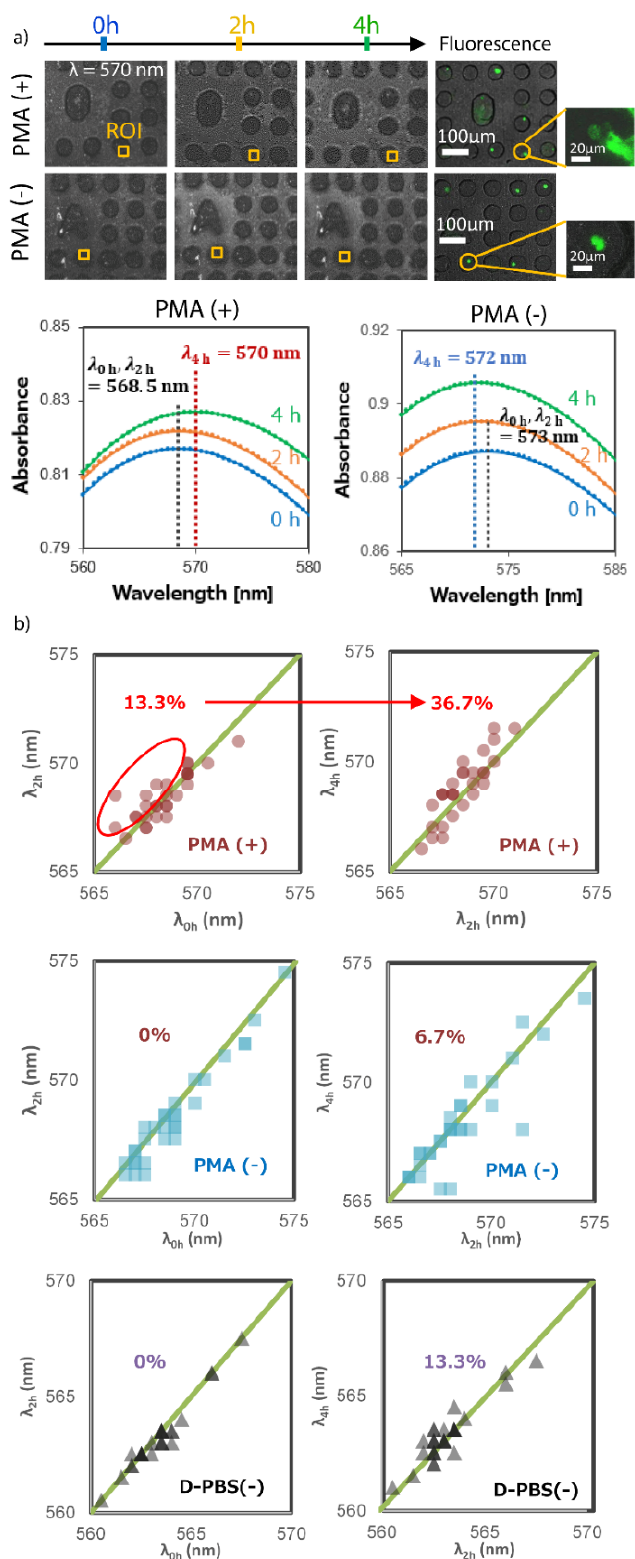
Figure 7. The real-time LSPR observation of single neutrophils cells: ( a ) The real-time LSPR observation of single neutrophils cells trapped in microwell at 570 nm wavelength over 4 h; ( b ) the distribution shift of 30 individual microwells with neutrophils and without